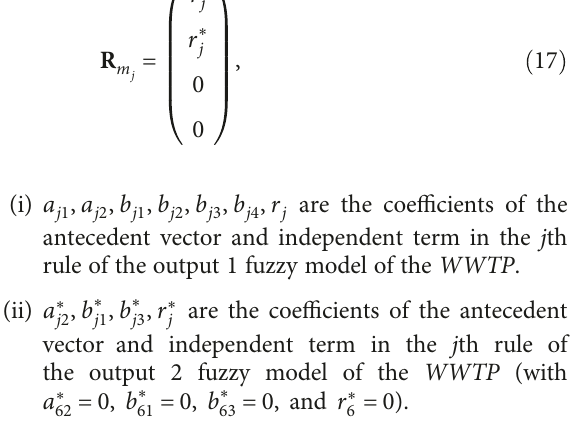
Figure 11: Predictive functional control-equivalence